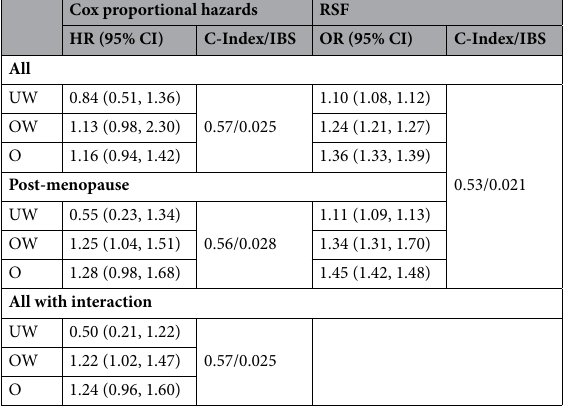
Table 1. Summary of Cox and RSF models reporting HRs and ORs for breast cancer incidence by weight status, when compared to normal weight